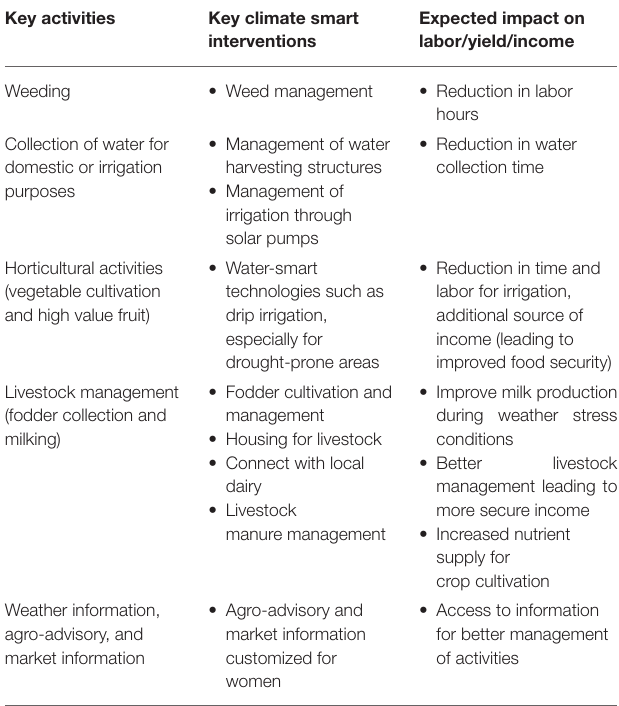
TABLE 2 | Selected women-led agricultural practices and CSA interventions,